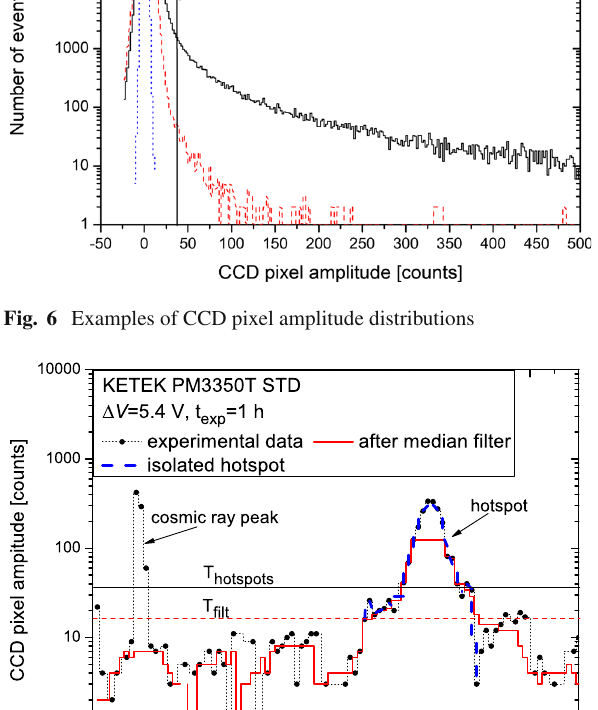
The suppression of the cosmic-ray peaks is clearly evident.